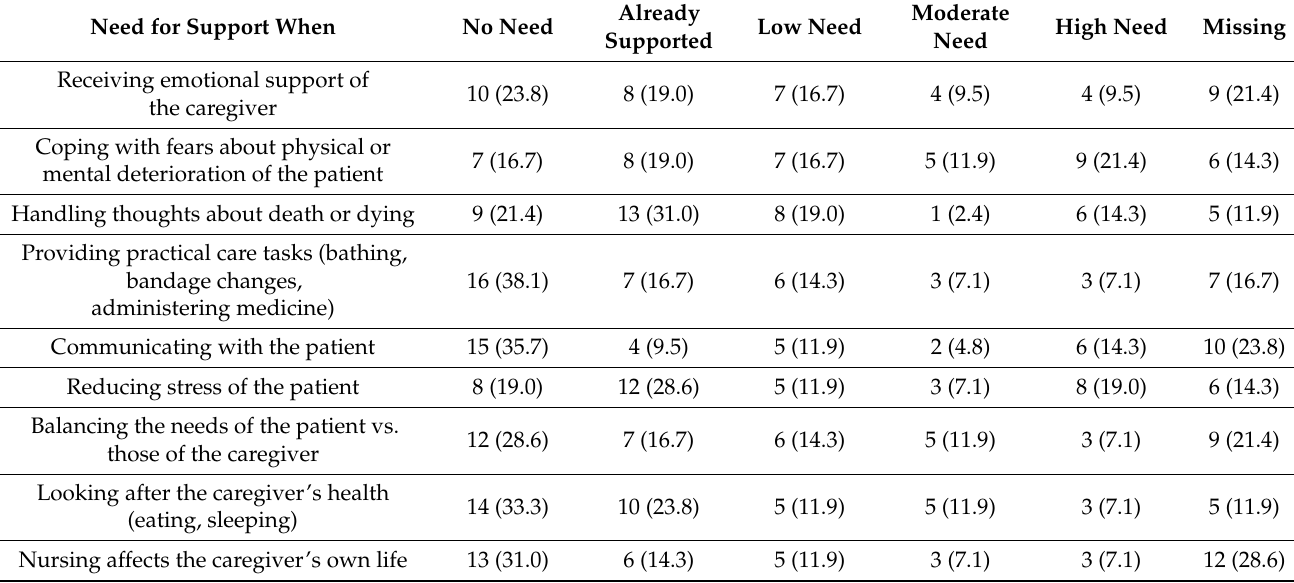
Table 4. The caregiver’s unmet needs, with data in total number ( n ) and percentage (%) for categori- cal